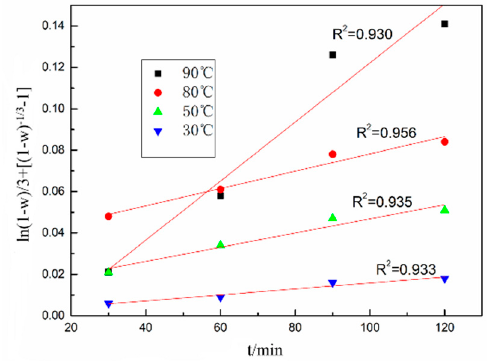
− 1/3 − 1 ] of cobalt leaching.